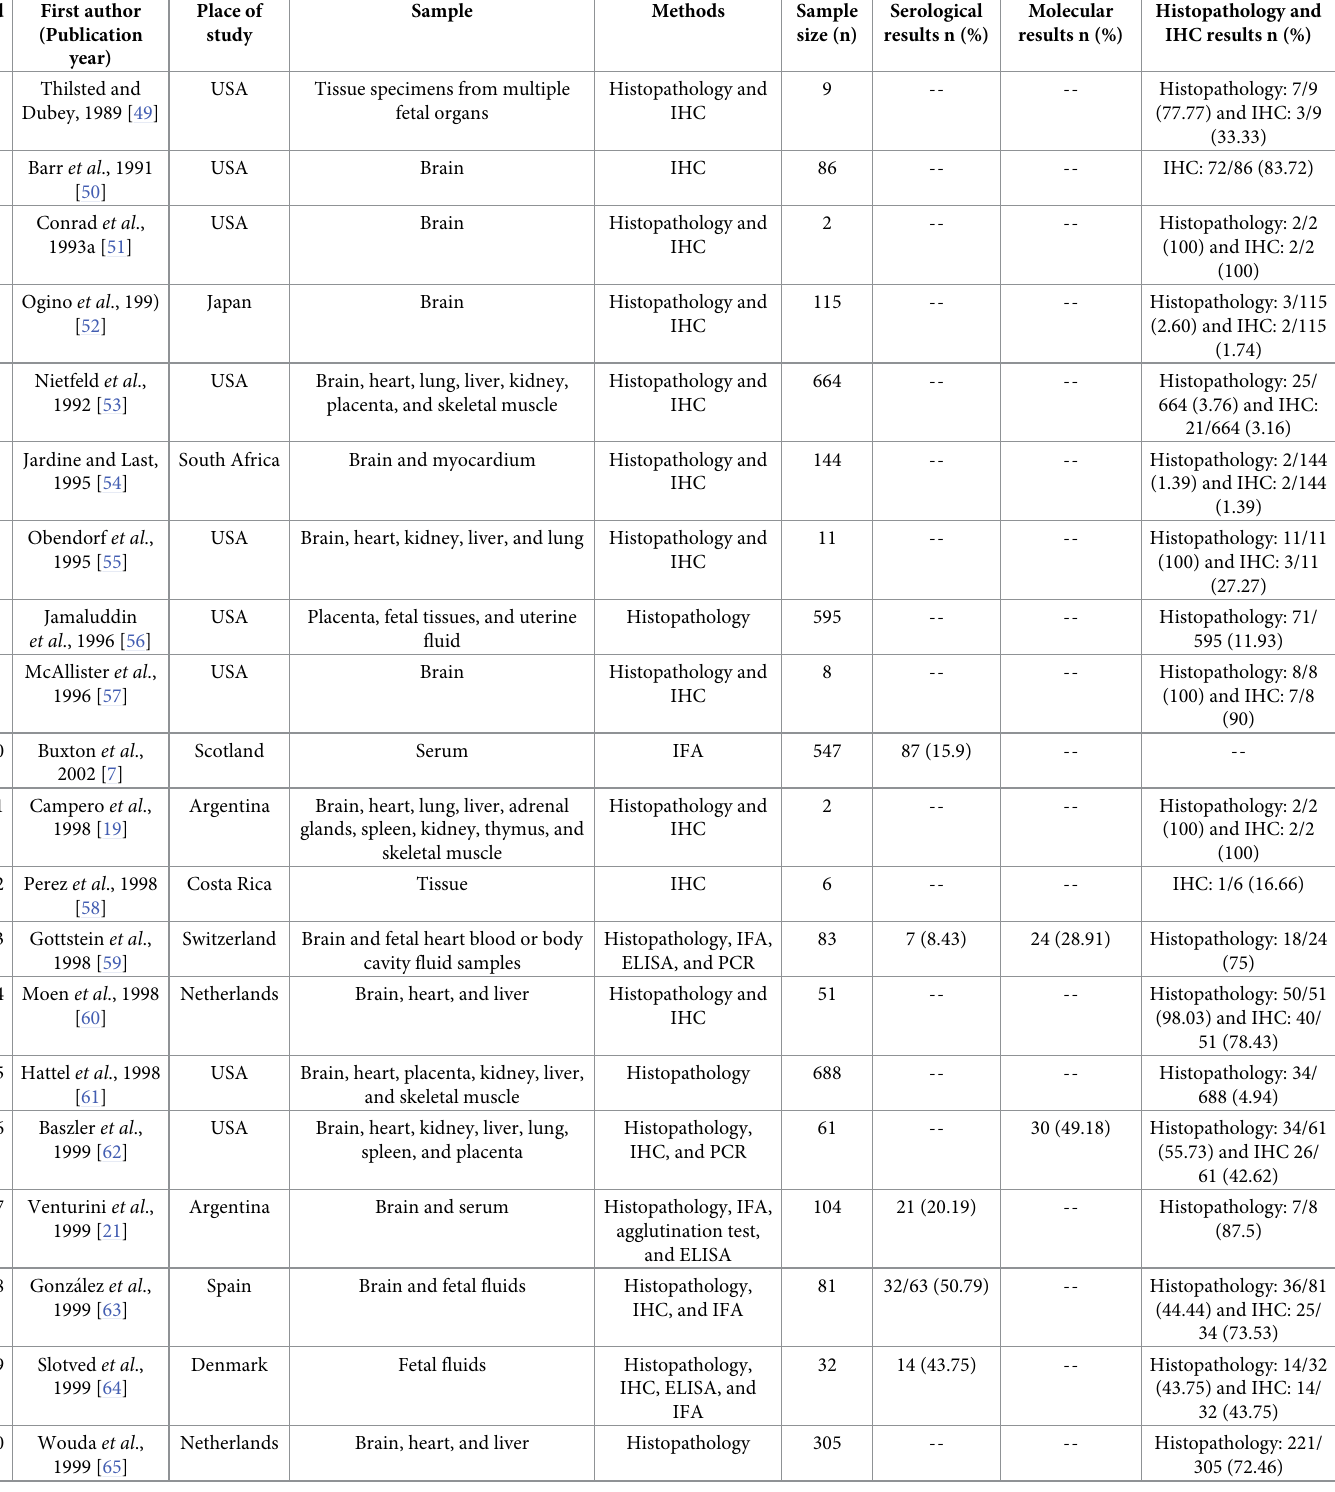
Table 2. Characteristics of the included studies for prevalence of N . caninum in the bovine aborted fetuses.